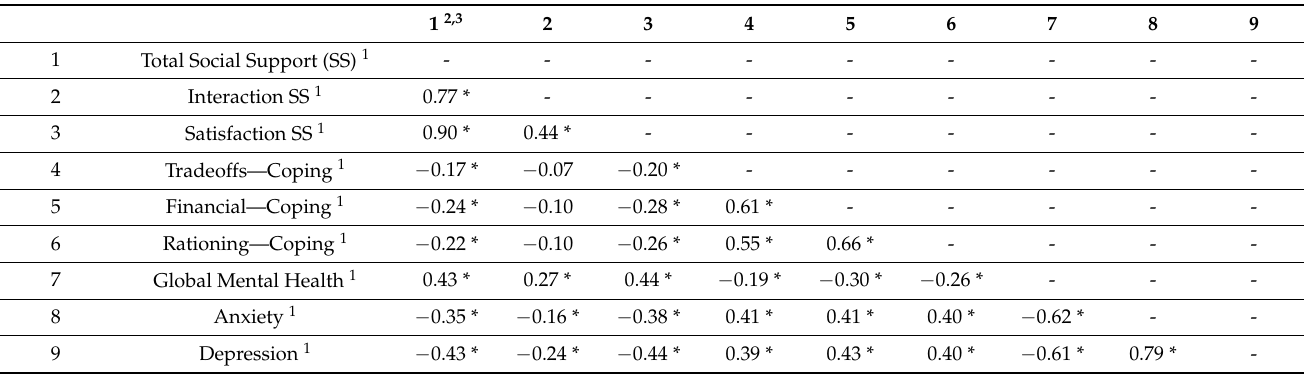
Table 2. Spearman’s correlations between mental health, social support, and coping outcomes in food-insecure mothers in Virginia ( n = 1029).